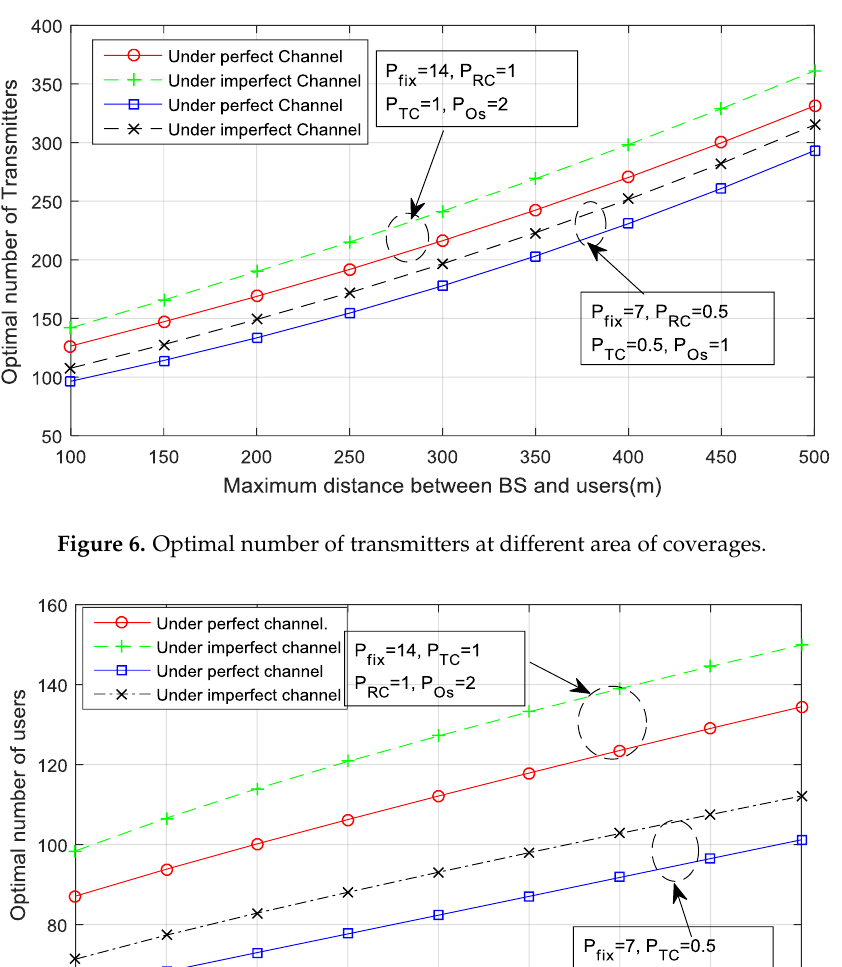
Figure 5. Distortion loses at different back-offs and power efficiencies.